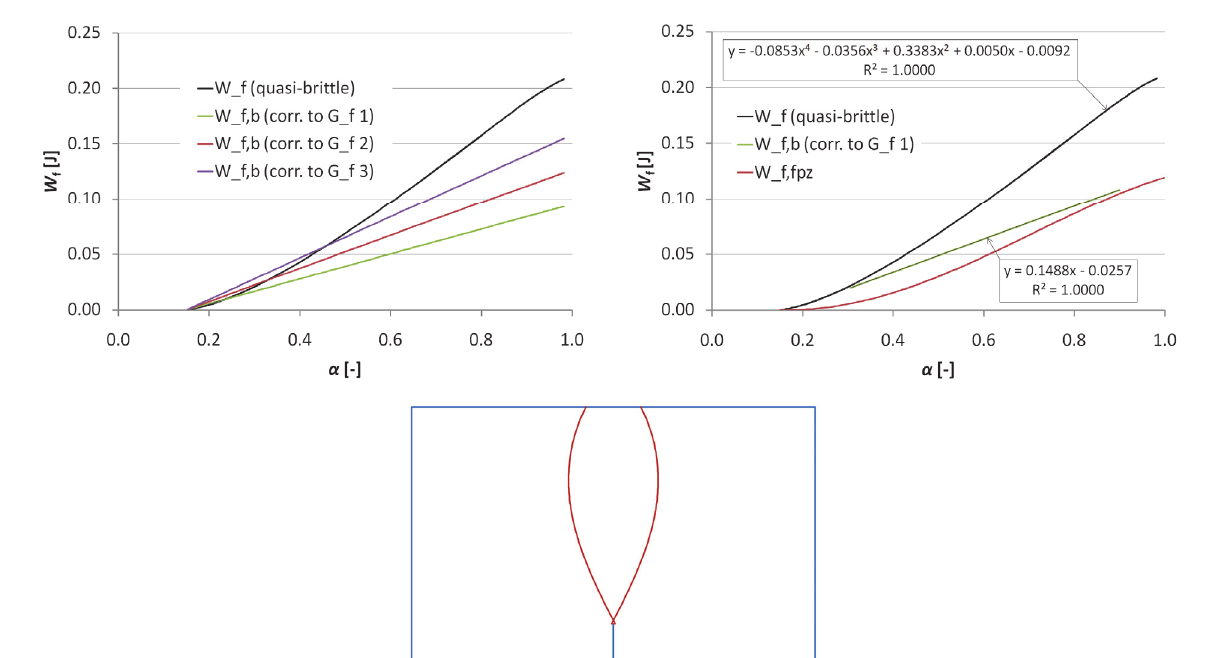
Figure 3: Plots of work of fracture due to quasi-brittle fracture W f ( a ) and brittle effective crack length propagation W f,b ( a ) (top left), their subtraction resulting in plot of cumulative energy dissipated in FPZ W f,fpz ( a ) (top right), and plot of FPZ envelope (bottom).